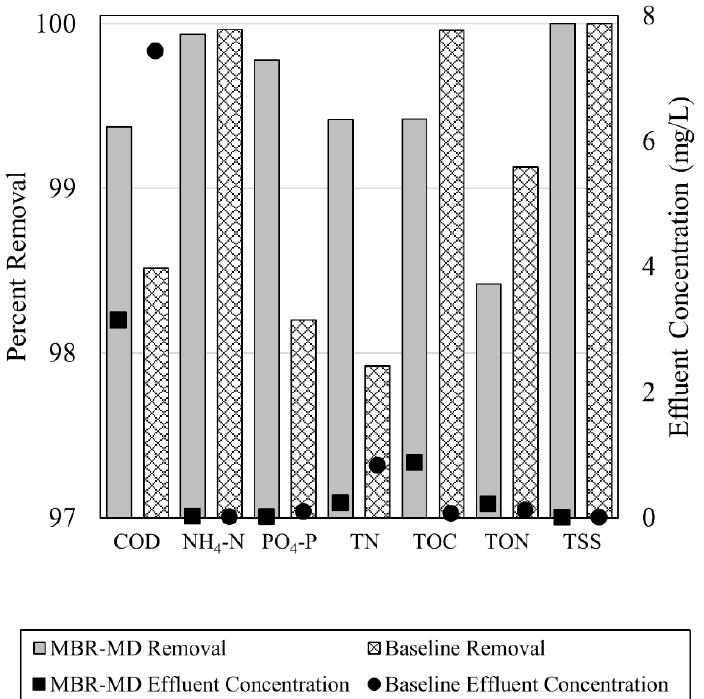
Figure 3. Effluent water quality results for the MBR-MD and Baseline system models and overall percent removal values for chemical oxygen demand (COD), ammonia (NH 4 –N), phosphate (PO 4 –P), total nitrogen (TN), total organic carbon (TOC), total organic nitrogen (TON), and total suspended solids (TSS).